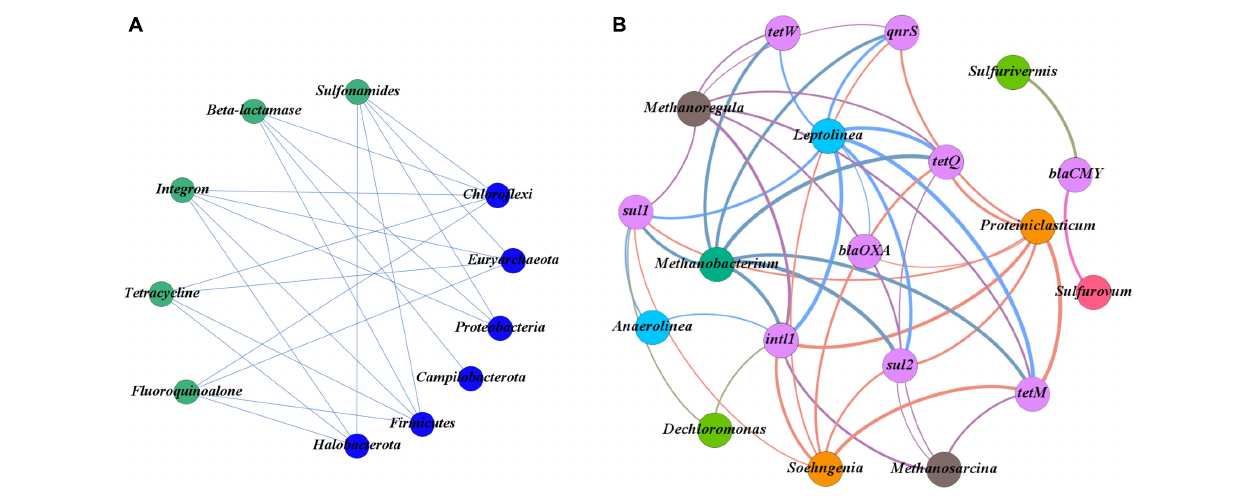
FIGURE 5 | (A) Network plots between antibiotic resistance genes (ARGs) and the phyla of the bacterial community. (B) Network plots between ARGs and the genera of the bacterial